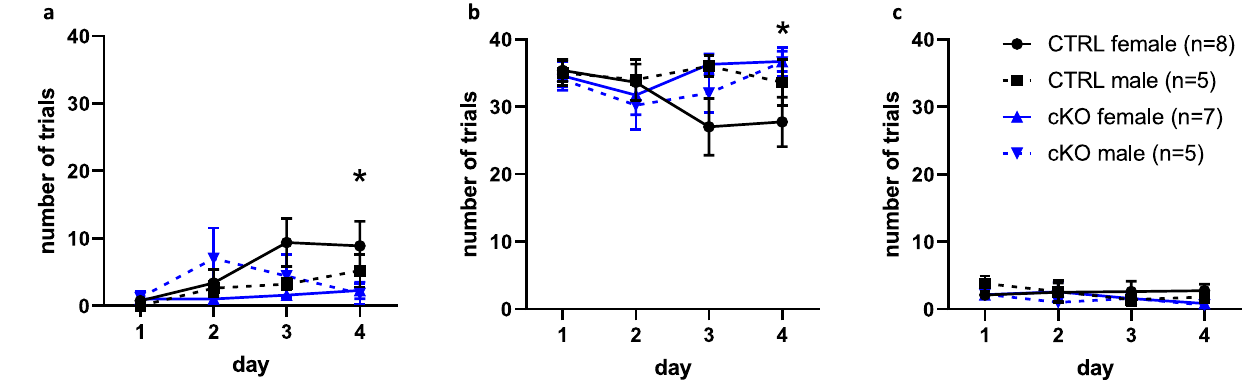
Figure 3. Neuronal Ca V 1.2 cKO mice have a deficit in associative learning. ( a ) Neuronal Ca V 1.2 cKO mice do not learn to leave on the light cue whereas CTRL mice do. We found a day × genotype interaction, and post hoc testing showed that cKO mice differed from CTRL mice on day 4. There were no sex-dependent effects. ( b ) Neuronal Ca V 1.2 cKO mice do not learn to avoid the air cue with trial initiation but CTRL mice do. There was a day × genotype interaction, and post hoc testing showed that cKO mice differed from CTRL mice on day 4. ( c ) There were no differences in how frequently mice walked onto the ladder before any cue was given, suggesting that mice did not display impulsive initiation of the task. Data are expressed as mean ± s.e.m, using